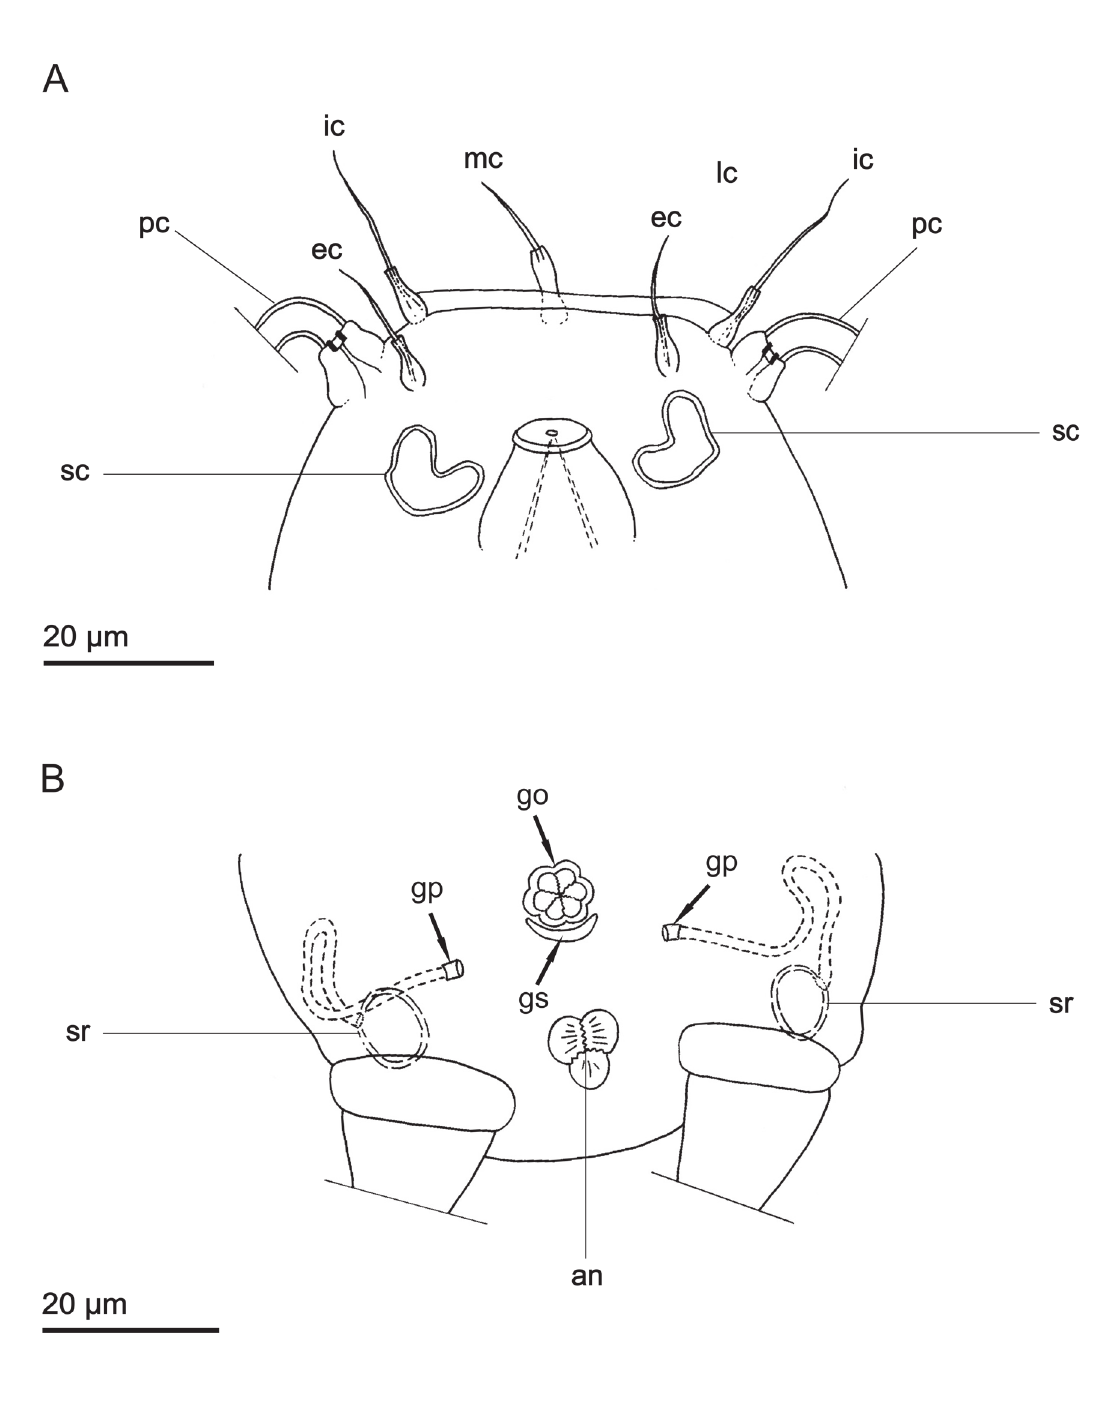
Fig. 17. Higginsarctus alatus (Gomes-Júnior, E. Santos, da Rocha, P.J.P. Santos & Fontoura, 2018) gen. et comb. nov. A . Paratype (C.VII-87). Close up on the head, ventral view showing the cephalic cirri and secondary clavae. B . Holotype (C.VII-84). Close up on the caudal region, ventral view showing the gonopore, genital stoup, anus and seminal receptacles with genital papillae. Abbreviations: see Material and methods. Drawing by Stine B.